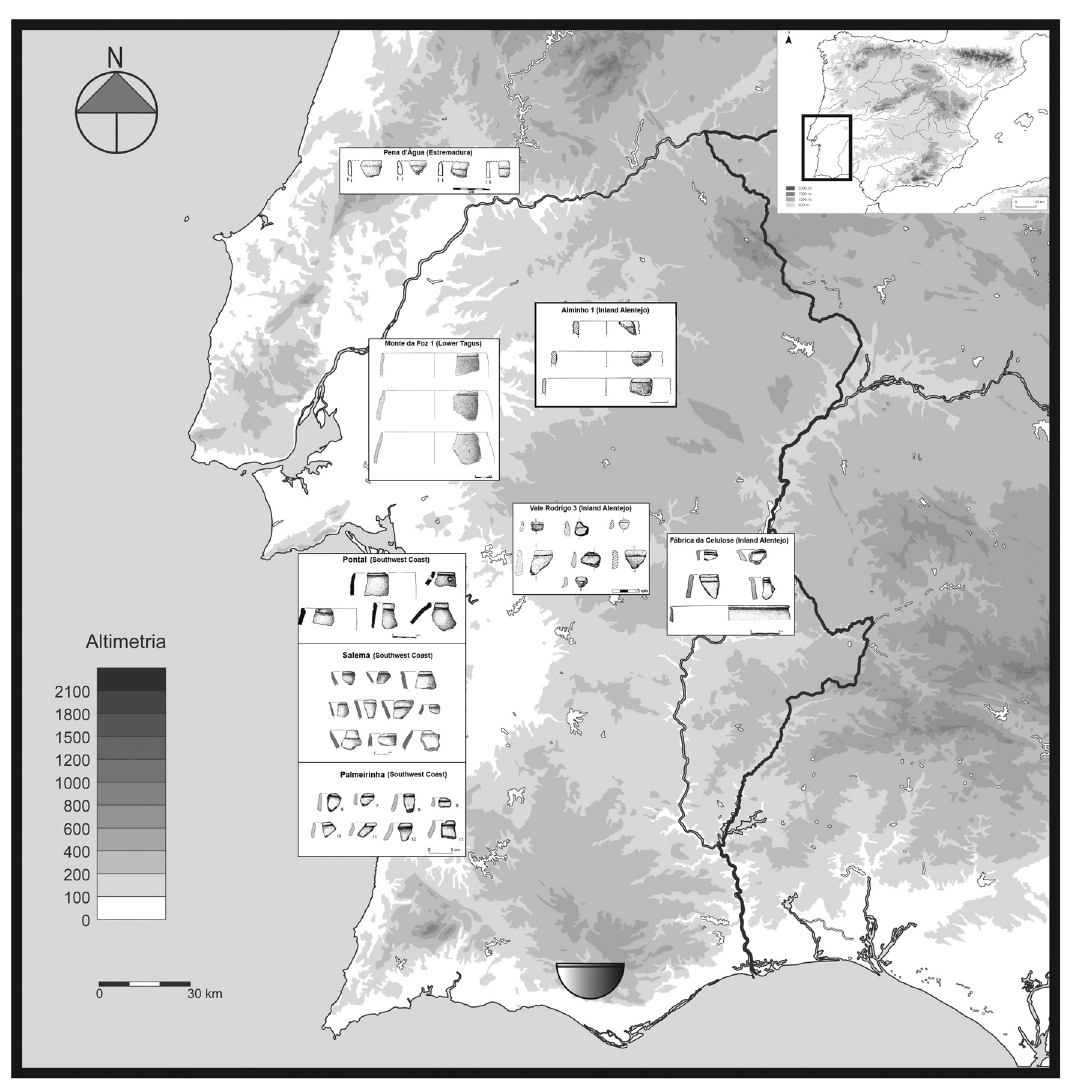
Figure 6: Initial Middle Neolithic. Pottery decoration systems distribution – incised line below the rim ( according to: Armbruester, 2006; Carvalho, 1998; Deus, 2008; Neves, 2010; Silva & Soares, 1981, 2018; Silva et al., 2010; Silva & Soares, 1980; basemap: Boaventura, 2009; Trabajos de Prehistoria for the map of Iberia )